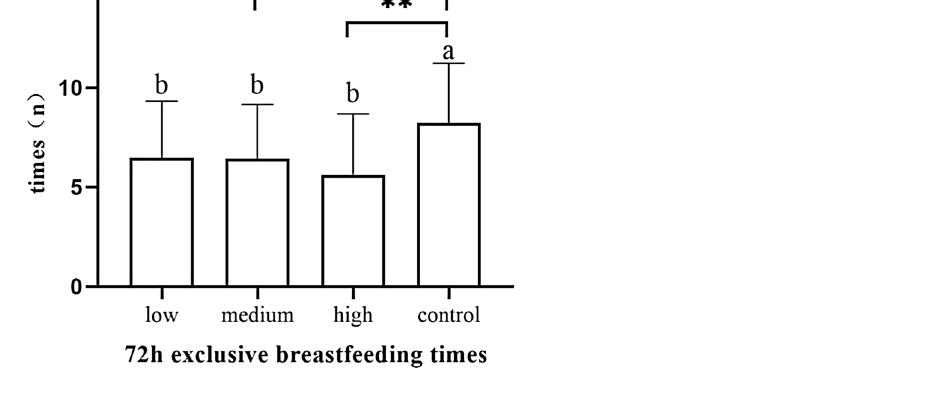
Figure 15. The number of exclusive breastfeeding sessions of 72 h.